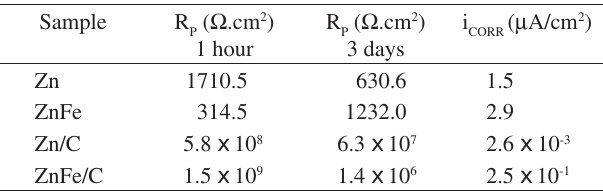
and i for all samples. P corr